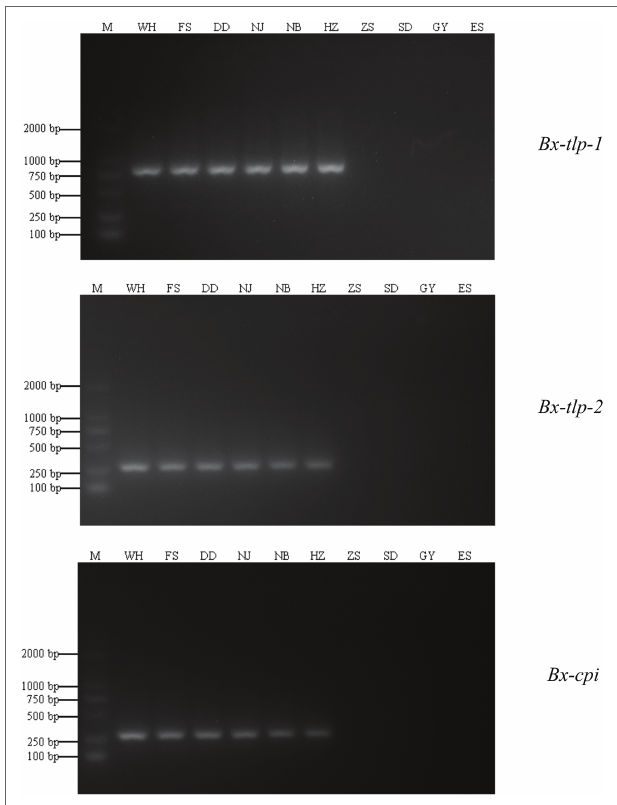
FIGURE 1 | Specificity of the PCR primers for Bursaphelenchus xylophilus and B. mucronatus genes encoding potential molecular mimicry proteins.